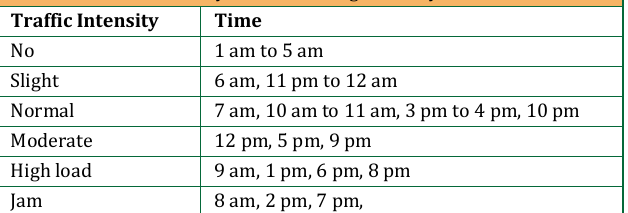
Table 1: Traffic Intensity w.r.t. time range in a day. Traffic Intensity